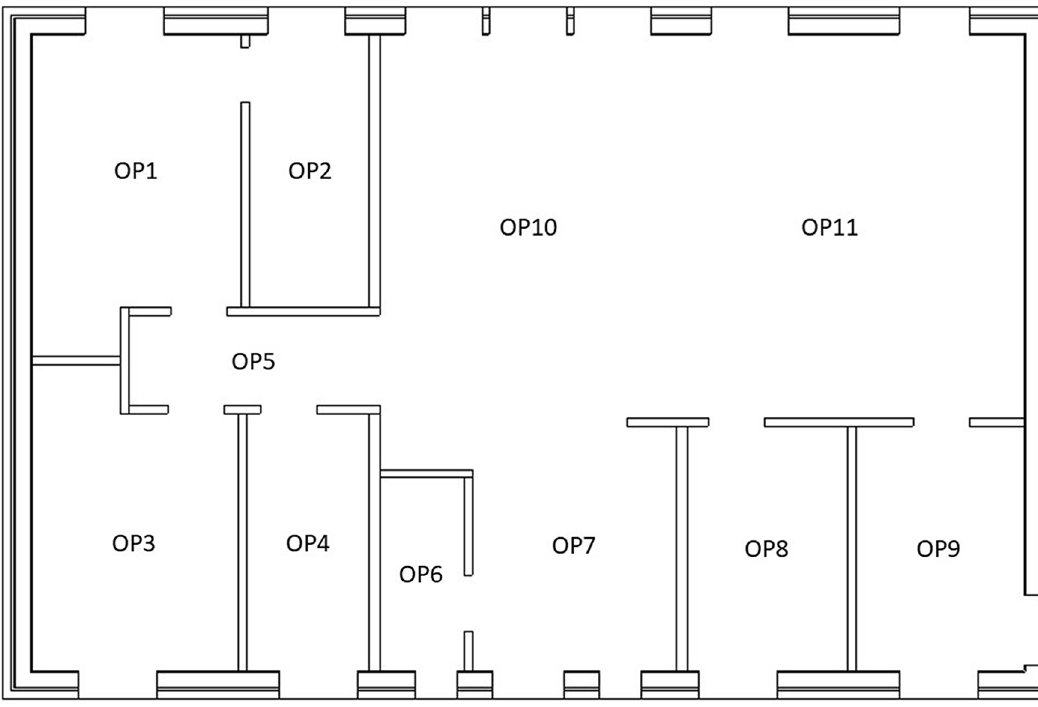
Figure 8. Observation points inside a typical Swedish house 6,7